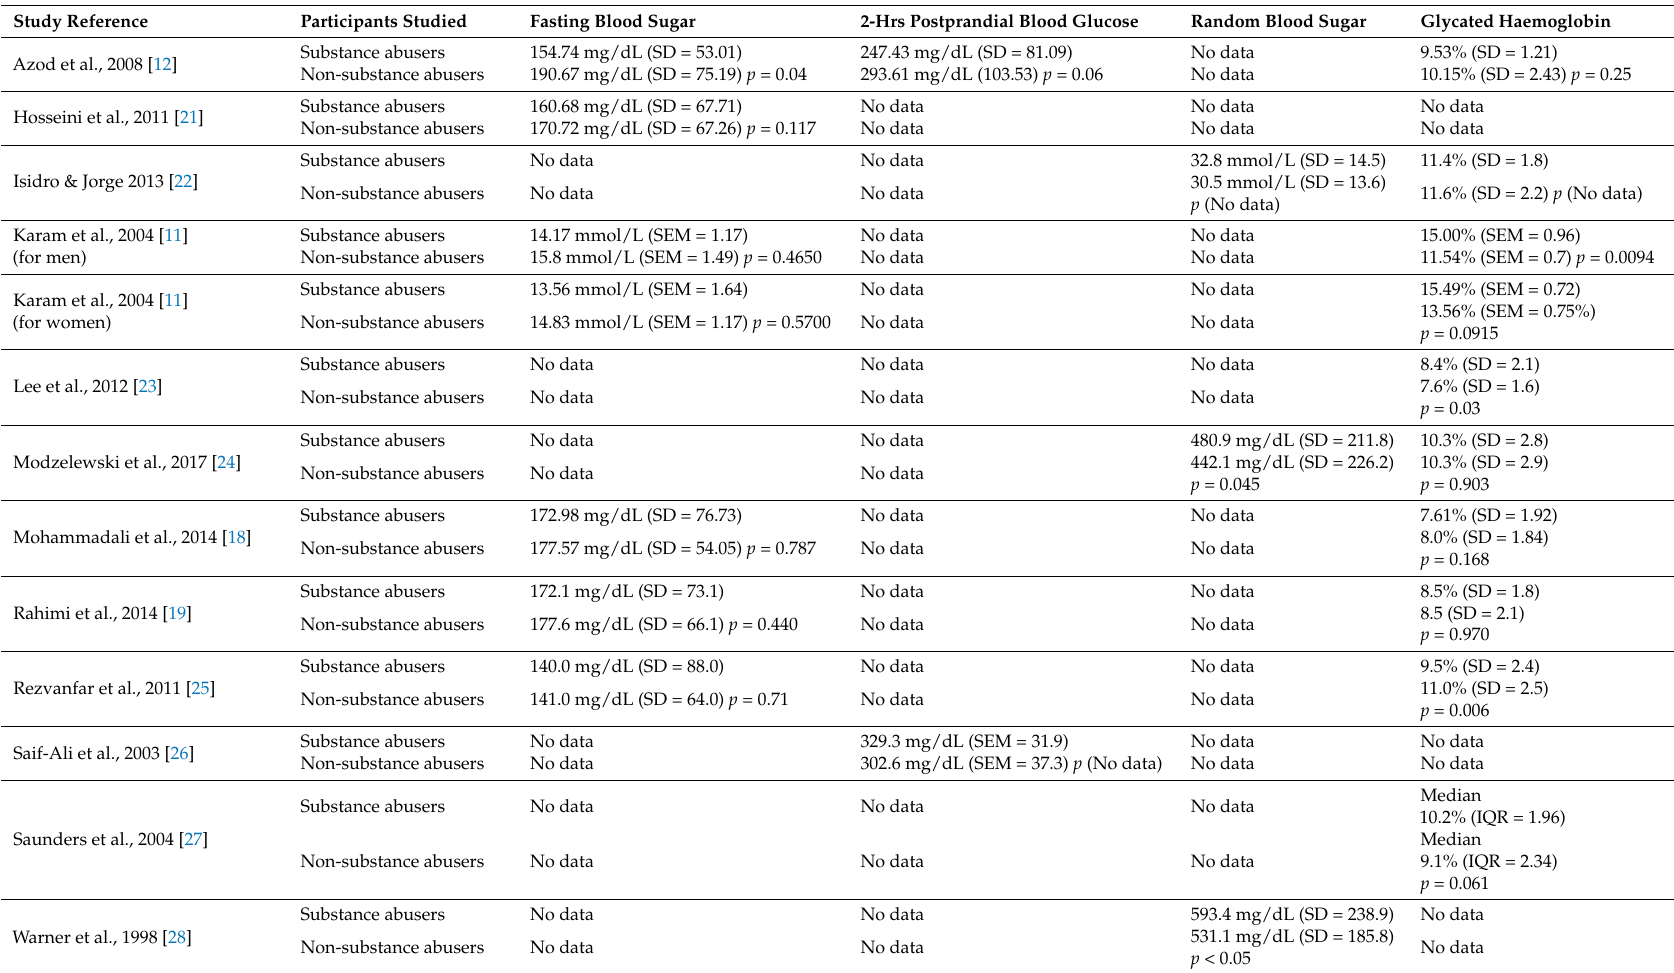
Table 3. Blood glucose parameters among individuals with diabetes based on their substance use